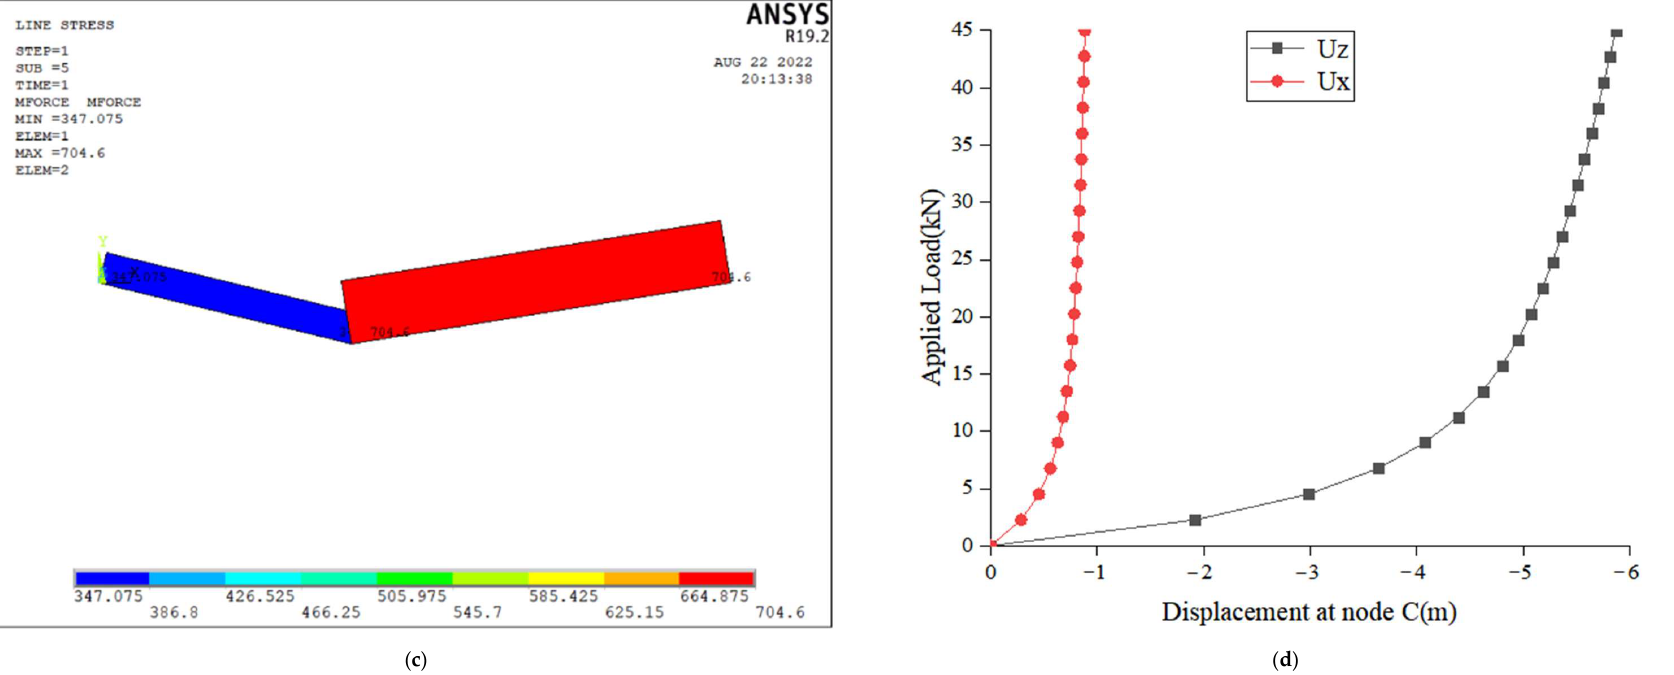
Figure 5. Calculated results for a single cable structure: ( a ) Vertical displacement, units in m; ( b ) Lateral displacement, units in m; ( c ) Axial force diagram, units in kN; ( d ) Load–displacement curve.